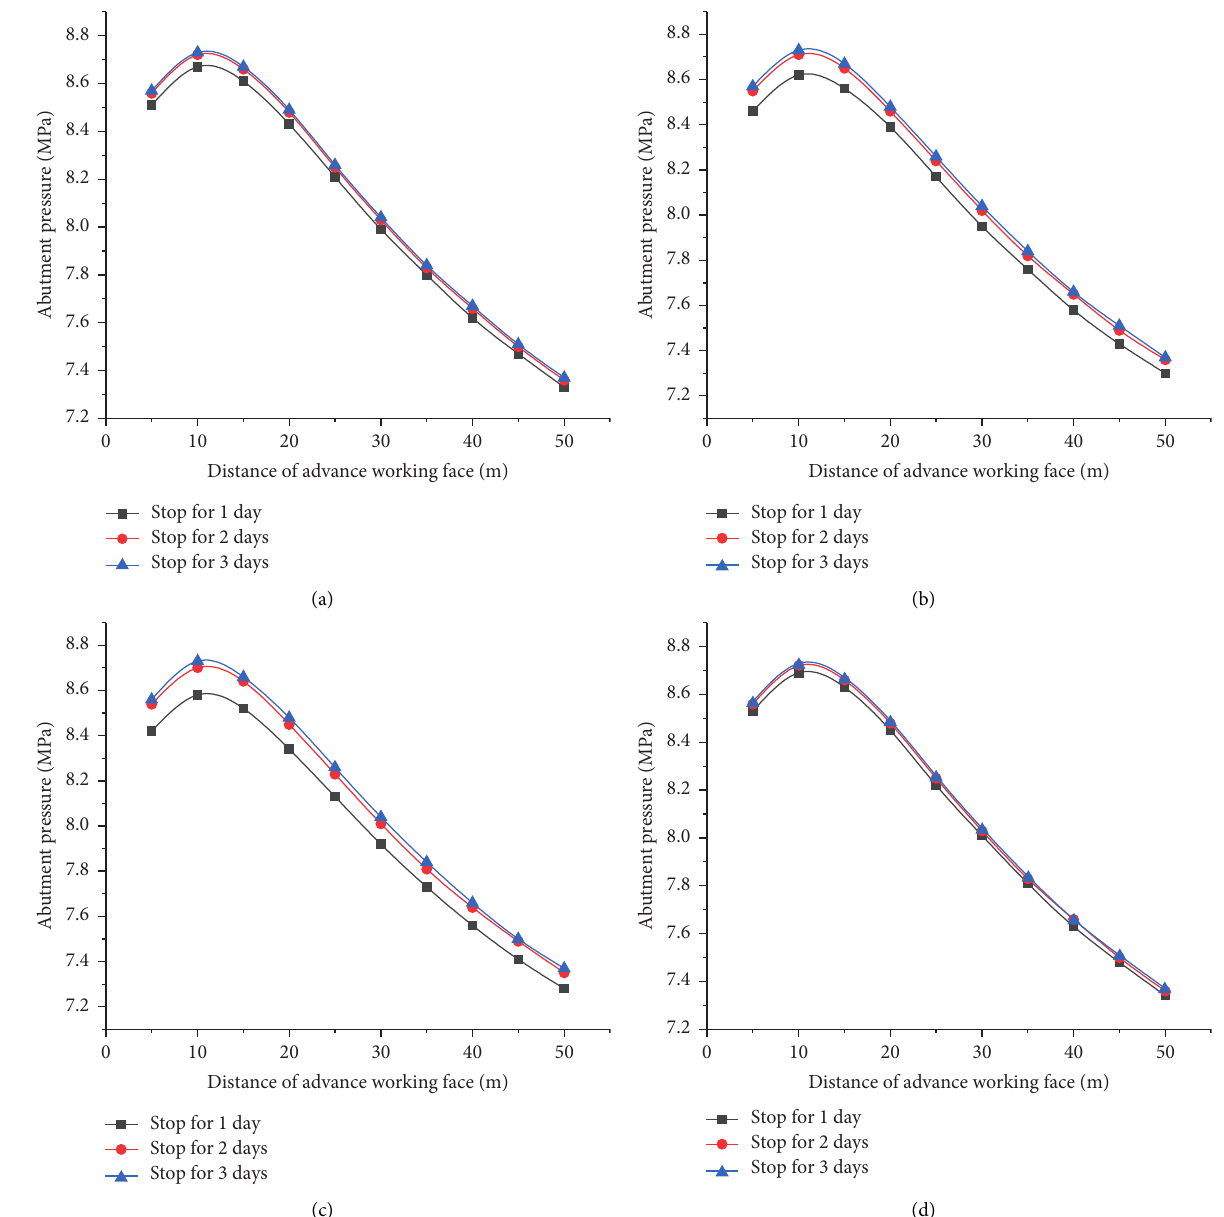
Figure 6: Distribution of advance support pressures at different stoppage times at different rates of advance. Advance speed of (a) 5m/d, (b) 10 m/d, (c) 15m/d, and (d)